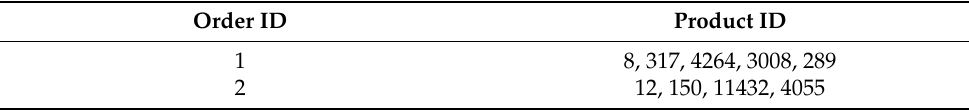
Table 3. Examples of departments .